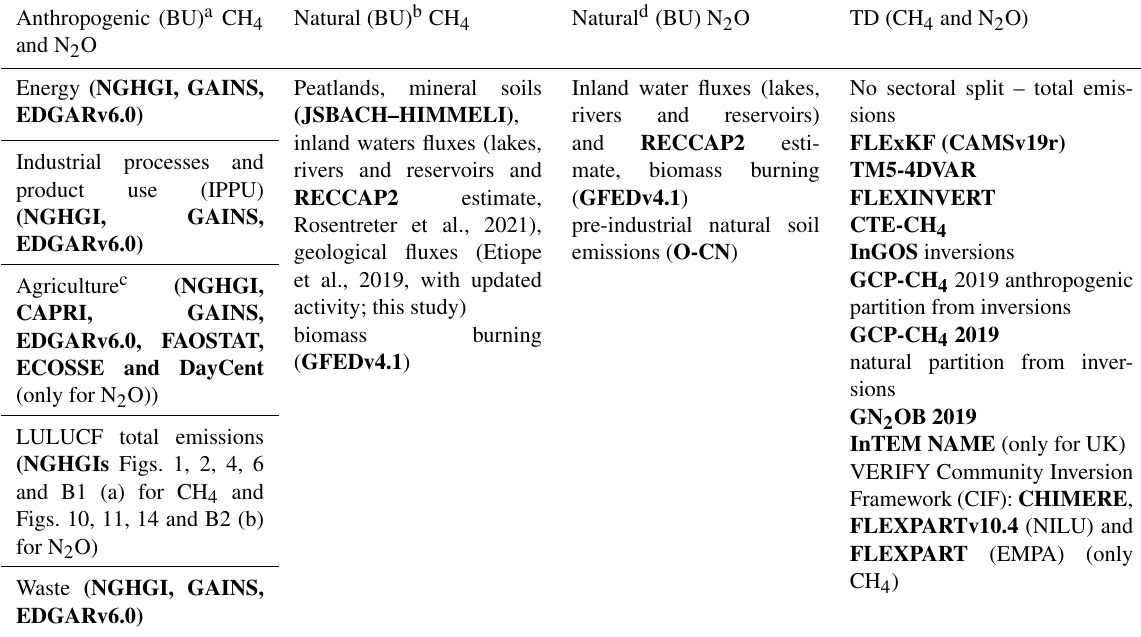
Table 1. Sectors included in this study and data sources (bold) providing estimates for these sectors. Anthropogenic (BU) a CH 4 and N 2 O Energy (NGHGI, GAINS, EDGARv6.0)